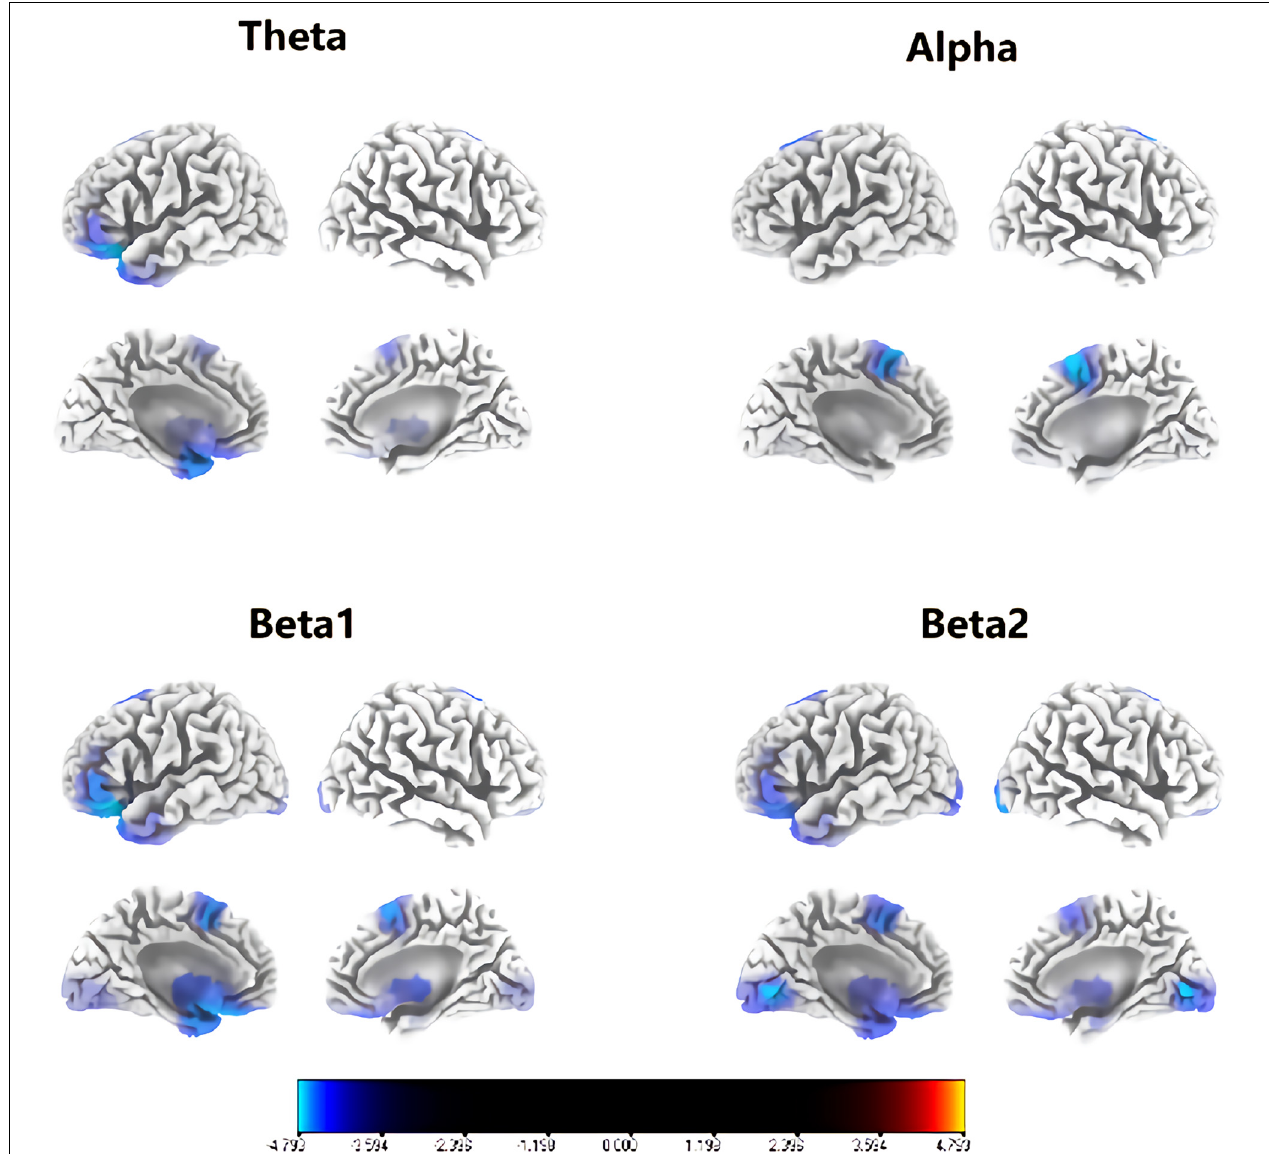
FIGURE 2 | Regions with significant group differences for each frequency in sLORETA analysis ( p < 0.05). Blue regions imply that the activity of the congenital cataract group was significantly lower than that of healthy